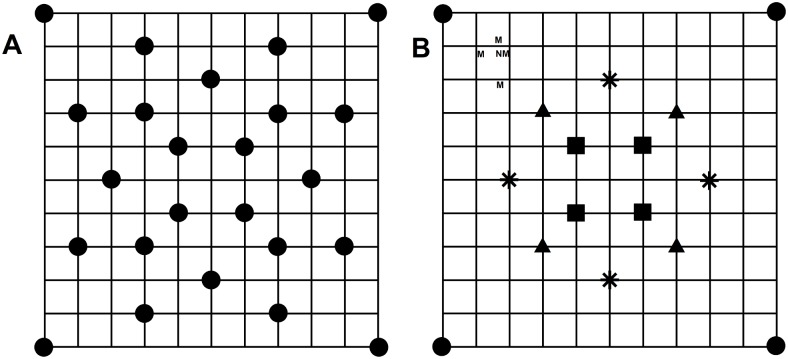
Layouts of microphone arrays used to record the sound environment.(A) Layout of full 24-microphone array used to record the ambient environment and (B) nested microphone subset arrays (● = 4, ■ = 8, ▲ = 12, and * = 16) used during noise introductions. As examples, the 8-microphone subset array included four central microphones (■) and four corner microphones (●), and the 12-microphone array included these 8 microphones plus four more (▲). ‘N’ represents a hypothetical location for noise introduction and each ‘M’ represents one of four additional microphones surrounding the noise source. The overall spatial extent is 60 m x 60 m for the entire plot and 6 m x 6 m for internal squares.